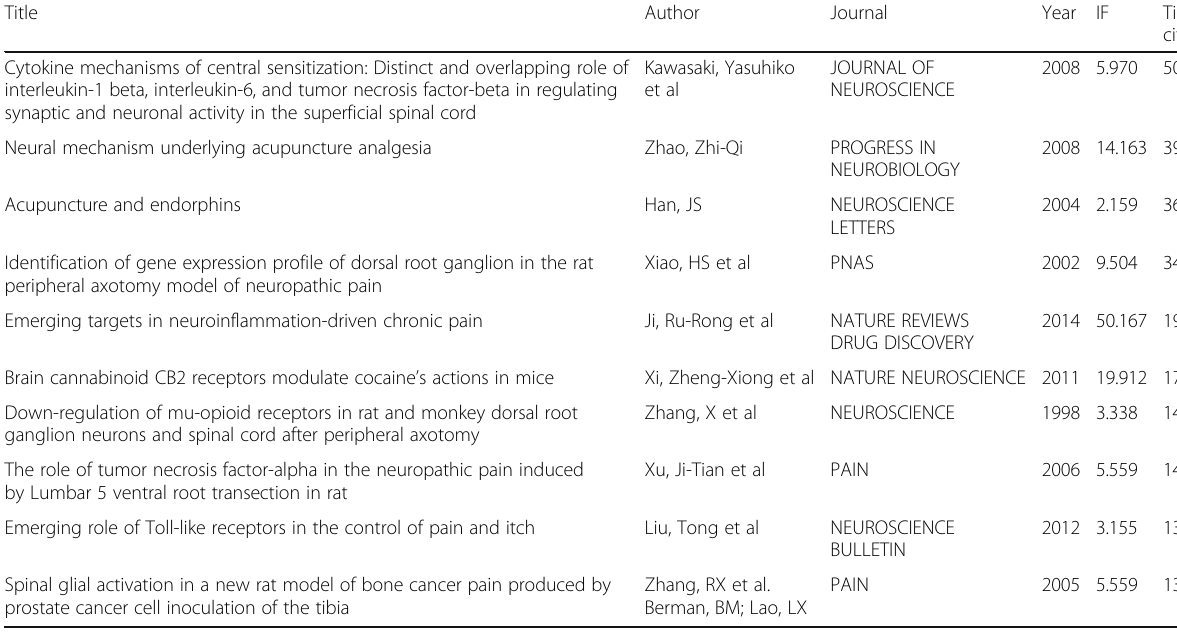
Table 2 The Top 10 most frequently cited articles on neuropathic pain in